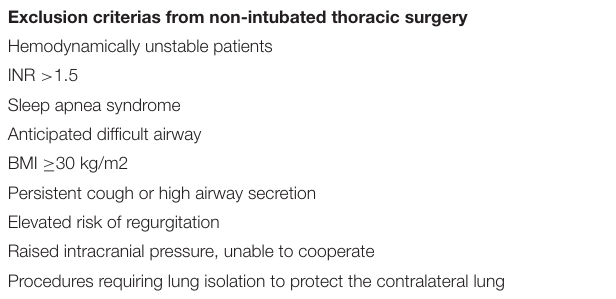
TABLE 2 | Exclusion criterias from non-intubated thoracic surgery. Exclusion criterias from non-intubated thoracic surgery Hemodynamically unstable patients INR >